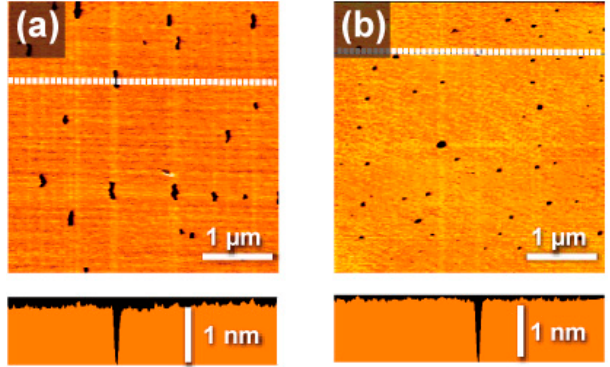
Figure 2. AFM (atomic-force microscopy) topographic images of the self-assembled monolayer (SAM) of 1 on mica. The fabrication was carried out through a dip-coating in a benzene ( a ) or toluene ( b ) solution of 1 (1 µmol L − 1 ). Lower images are the cross section along the dashed lines shown in the topographic images.